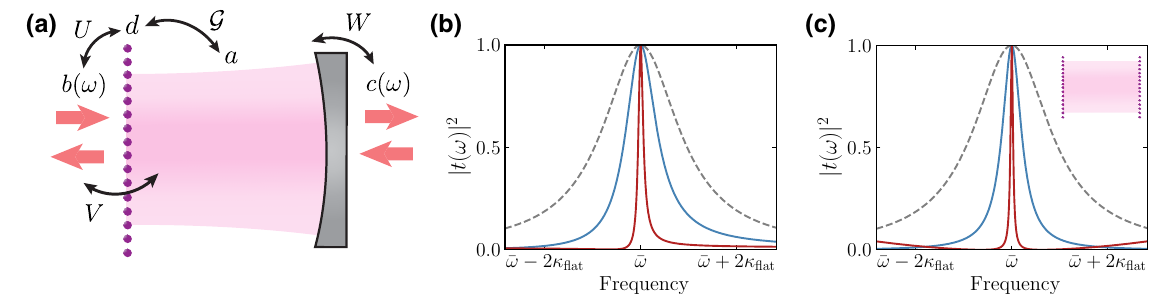
FIG. 12. (a) A hybrid cavity comprised of an atomic array (left mirror) and a standard, flat frequency mirror (right). The cavity mode a interacts with two external continua b (ω) , c (ω) , and the surface-confined mode on the array d . (b) Cavity response for ζ 0 = 10. The gray dashed line is the expected Lorentzian profile with linewidth κ flat = ω FSR /( 2 πζ 2 narrower mirror linewidths γ d = ω FSR / 10 (blue curve) and γ d = ω FSR / 100 (red curve), the cavity shows an asymmetric transmission profile with a strongly reduced linewidth at the level of γ d /ζ 0 . (c) Transmission profile for a double-sided hybrid cavity, where also the right mirror is replaced by an atomic array [same values for γ d as in (b)] shows a symmetric response with an even narrower